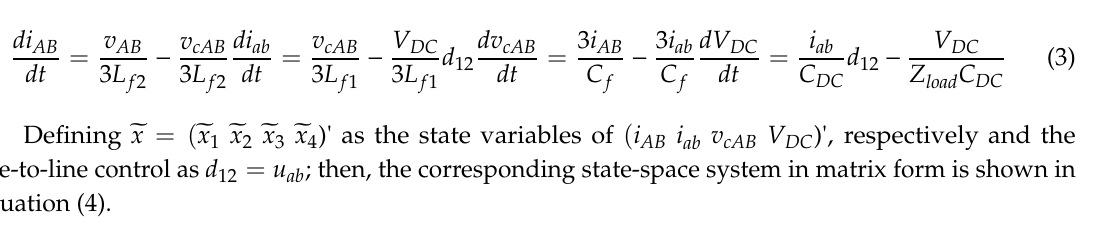
Figure 2. Equivalent line-to-line 𝑣 (cid:3002)(cid:3003) PWM rectifier circuit.